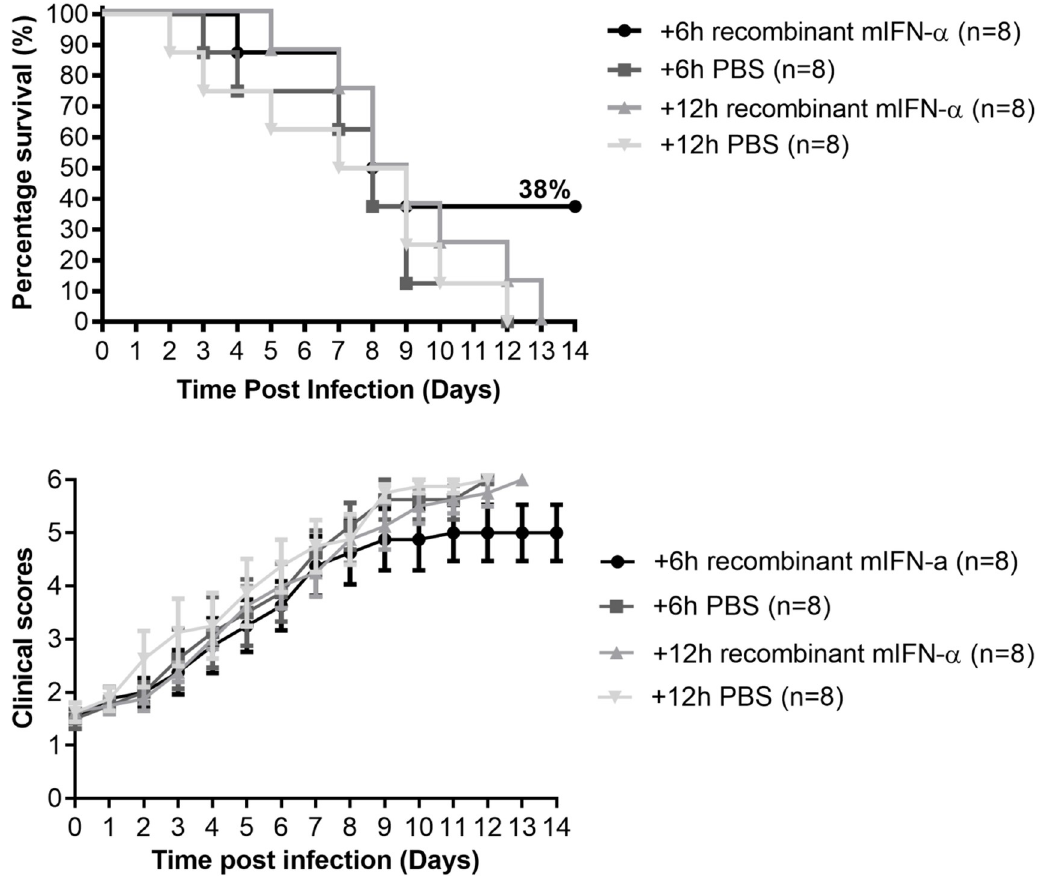
Fig 7. 6–day-old BALB/c mice were infected with CHIKV at 5 x 10 5 PFU per mouse and treated with 100 U/g of recombinant mIFN- α or equal volume of PBS at 6 hpi or 12 hpi to 7 dpi on daily basis (n = 8 mice per group). (A) Survival was monitored daily for 14 days and displayed as Kaplan-Meier survival curves. (B) Mice were scored based on activity, breathing, movement and body weight change daily (S1